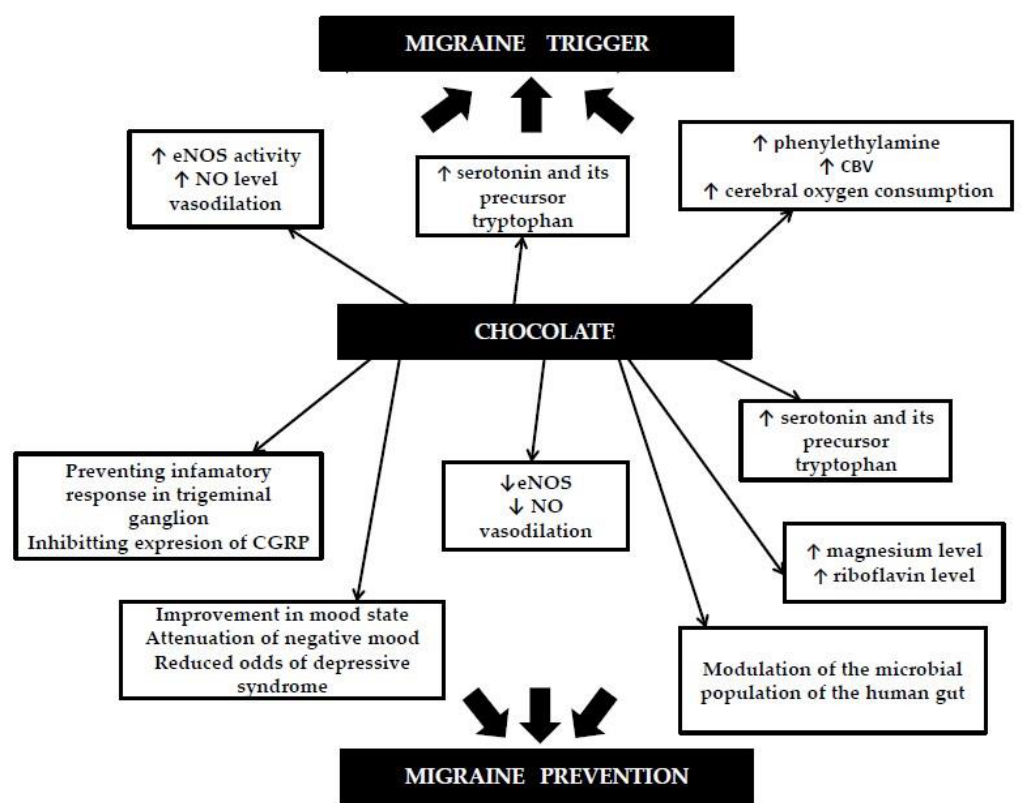
Figure 1. Possible mechanisms by which chocolate may trigger or prevent migraine attacks (based on our literature